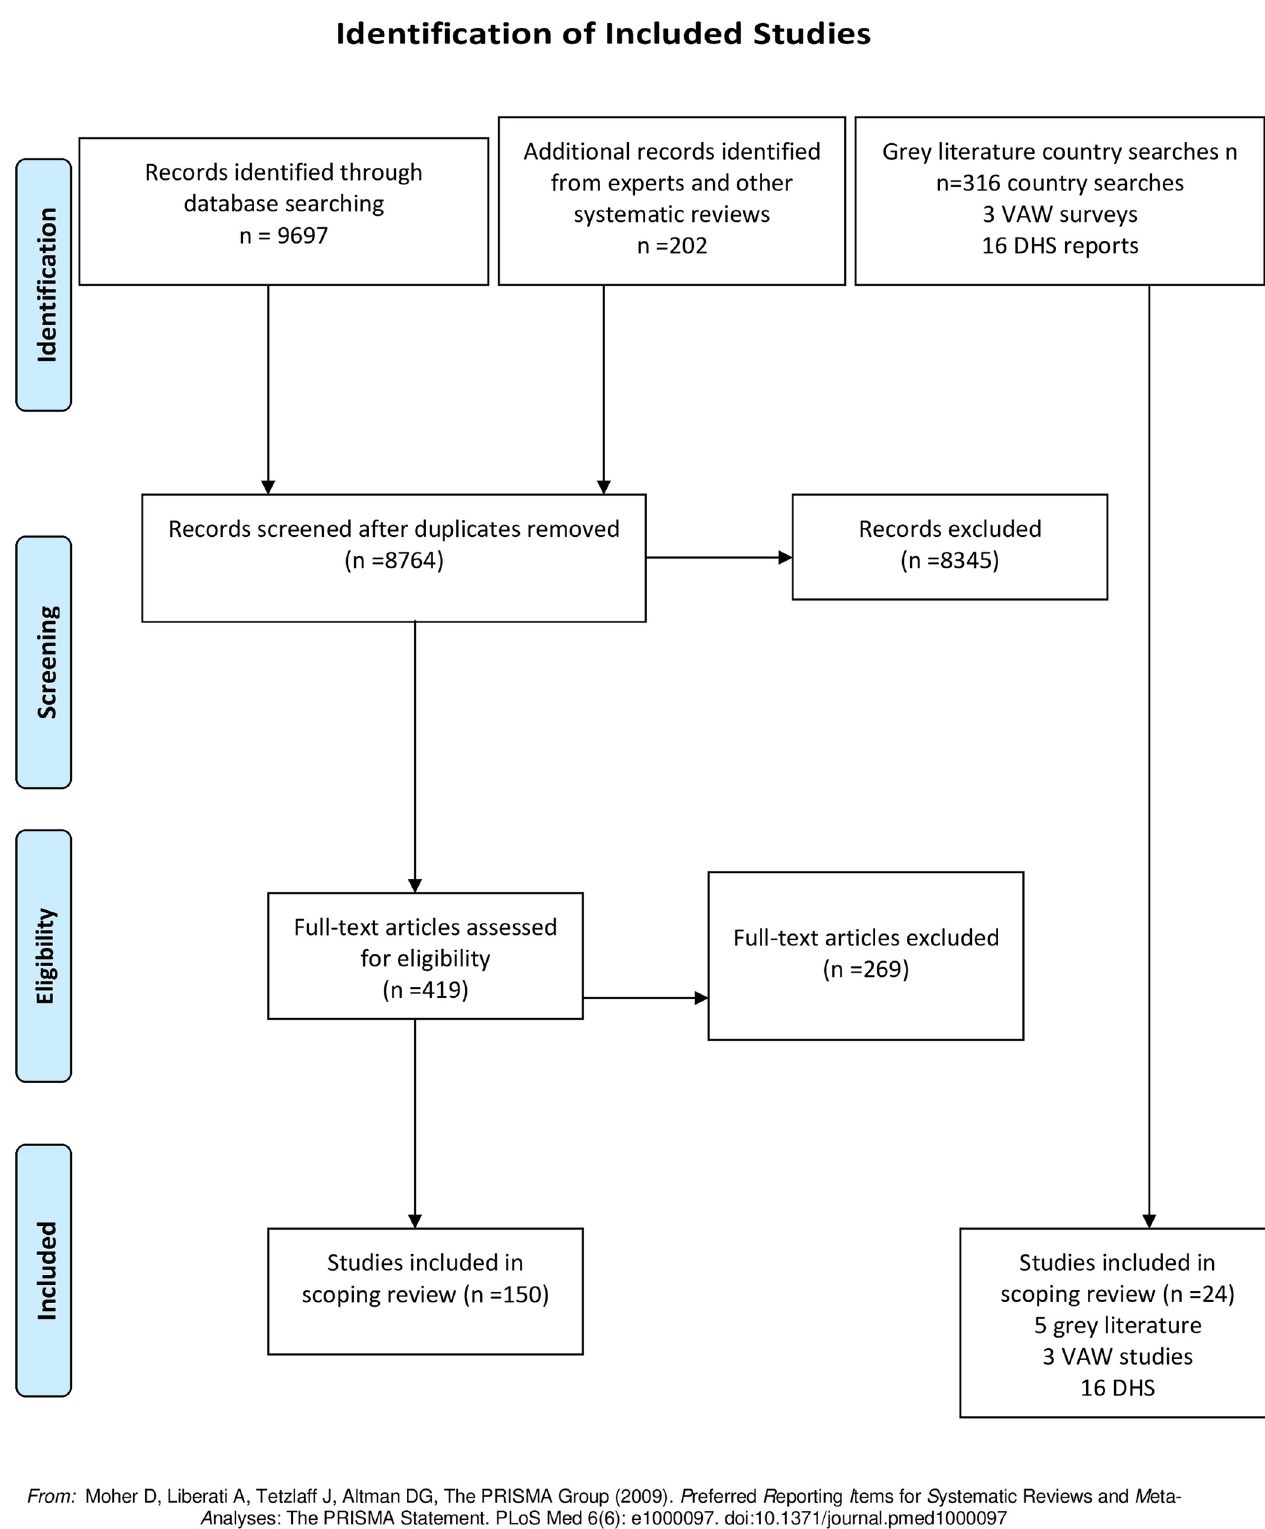
Fig 1. Identification of included